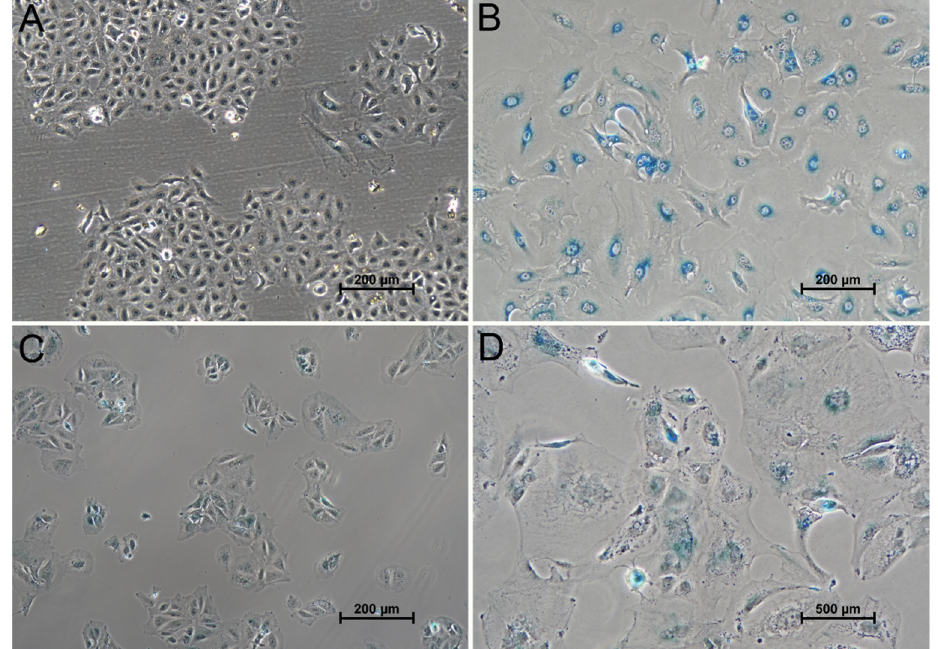
Figure 7. Senescence-associated β-galactosidase staining of A549 and HuH-7 cells. X-Gal-staining of A549 ( A , B ) and HuH-7 ( C , D ) revealed mostly negative cells in untreated control samples ( A , C ). Isolated cells showed weak X-Gal positive staining, which was accompanied by a larger cell size and a slightly different cell morphology compared to those cells that were X-Gal-negative. After irradiation with 16 Gy, almost all A549 cells became X-Gal-positive (99%) and most HuH-7 showed positive staining (81%).